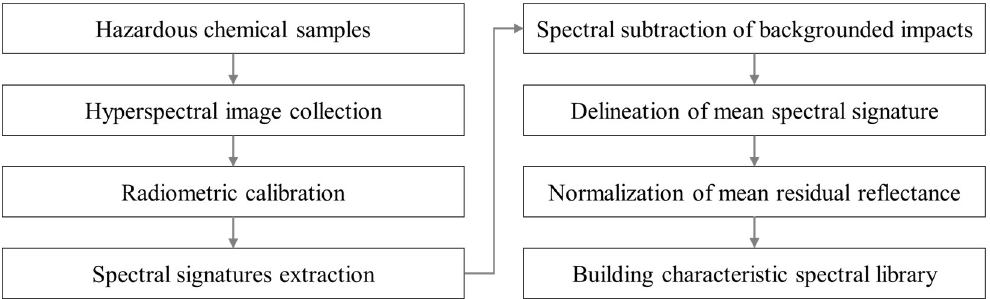
Figure 10. A flow chart to describe an end-to-end step for building characteristic spectral library for hazardous chemicals proposed solvent in rivers.